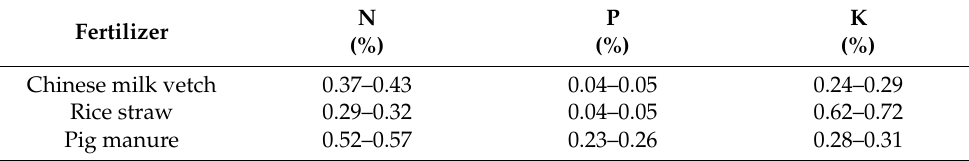
Table 3. The characteristics of Chinese milk vetch, rice straw, and pig manure (fresh).